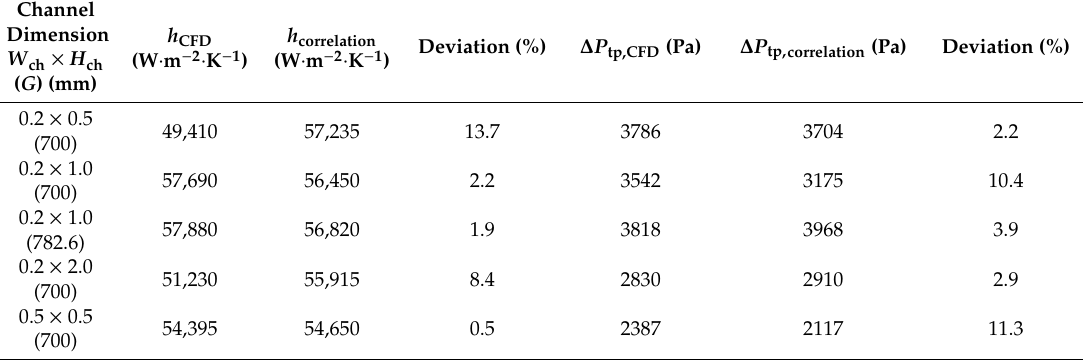
Table 3. Comparison of heat transfer coe ffi cient and two-phase pressure drop determined by the numerical simulations and the